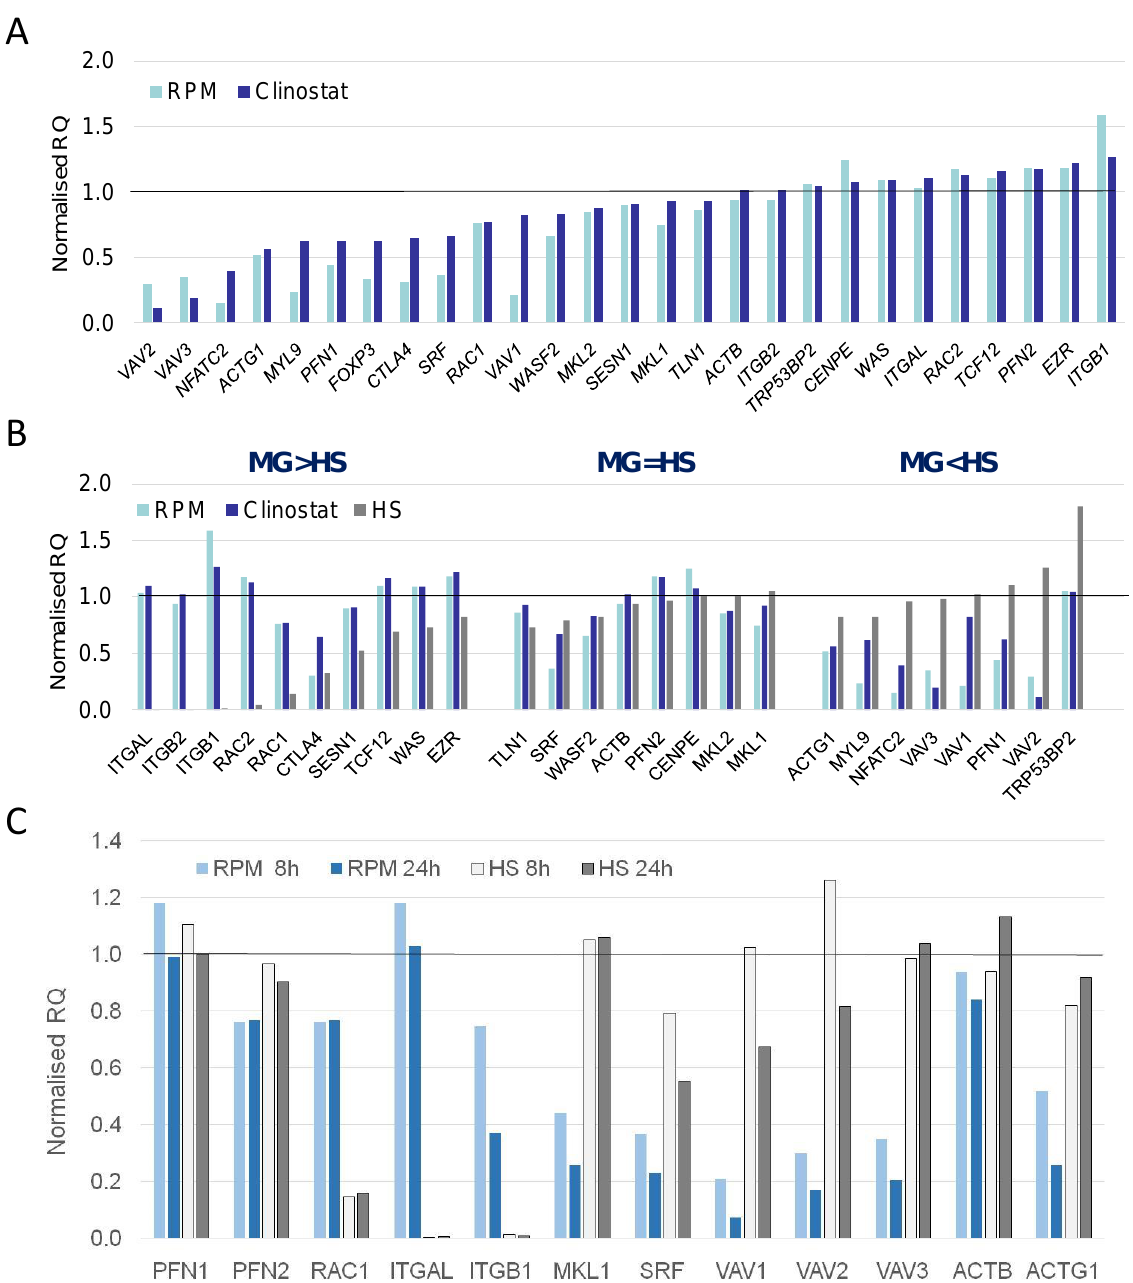
Figure 5. Differentially expressed genes in human T cells (Jurkat) in simulated microgravity experiment measured by RT-qPCR. ( A ) Actin cytoskeleton network differential gene expression response to simulated microgravity . Differential expression of 27 genes measured at 8 h of simulated microgravity in random positioning machine (RPM) or clinostat and normalized by values of non- treated control (RQ value equals 1.0). ( B ) Candidate marker genes discriminating T cell responses to simulated microgravity and to hydrodynamic stress . Differential expression measured at 8 h of treatment in random positioning machine (RPM), clinostat, or hydrodynamic cell stress-inducing platform (HS). Genes grouped according to T cell responses in MG and HS for gene expression higher in simulated microgravity (MG > HS) or in hydrodynamic stress treatment (MG < HS) or in a similar range (MG = HS). ( C ) Dynamic expression of actin network selected key genes in simulated microgravity versus hydrodynamic stress response . Differential expression measured at 8 h and 24 h of treatment in random positioning machine (RPM) or hydrodynamic stress-inducing platform (HS) and normalized by non-treated control (NTC) values (RQ value equals